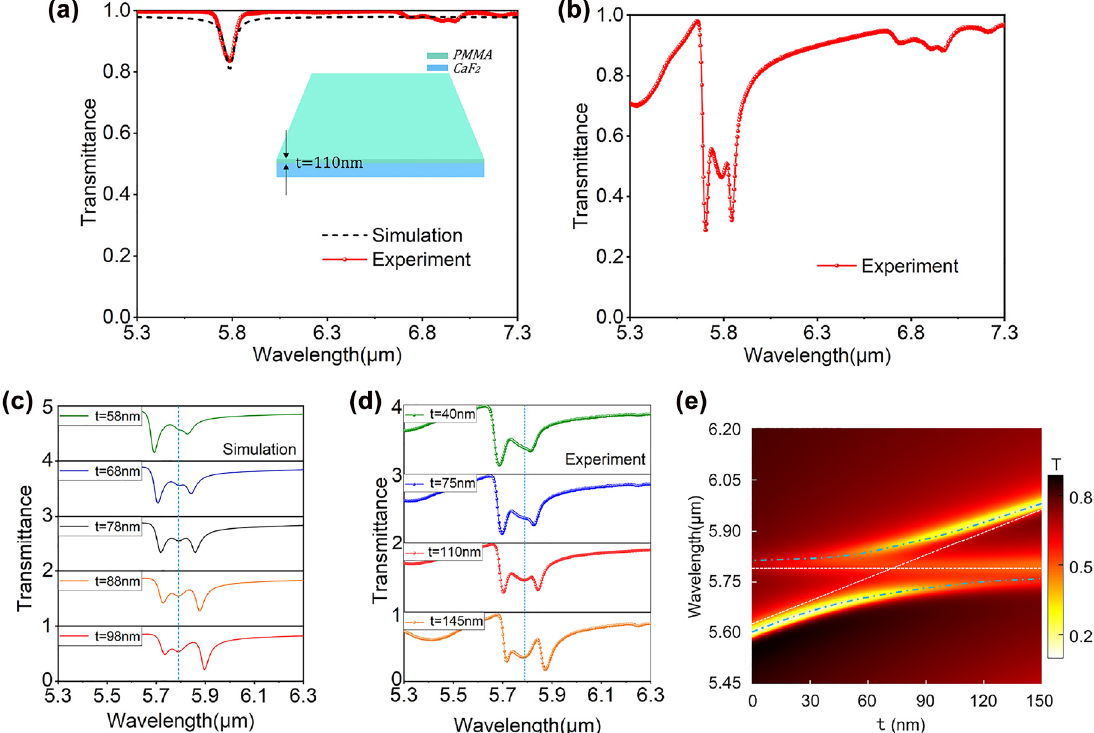
Figure 5: Theoretical simulation and experimental characterization of strong coupling under different PMMA film thicknesses. (a) Measured substrate, exhibiting a good agreement with the calculations based transmission spectrum of the PMMA layer with t = 110 nm on a bare CaF 2 on the Lorentz model. (b) Transmission spectra measured when the sample was spin-coated with a 110 nm PMMA layer. (c) Calculated transmission spectra for different PMMA thicknesses ( t = 58, 68, 78, 88, and 98 nm. (d) Experimentally measured transmission spectra for different PMMA thicknesses ( t = 40, 75, 110, 145 nm). The blue vertical dashed lines in (c) and (d) represent the position of the vibrational resonance of PMMA molecules. (e) Transmission spectra of the hybrid structure with different PMMA thickness t